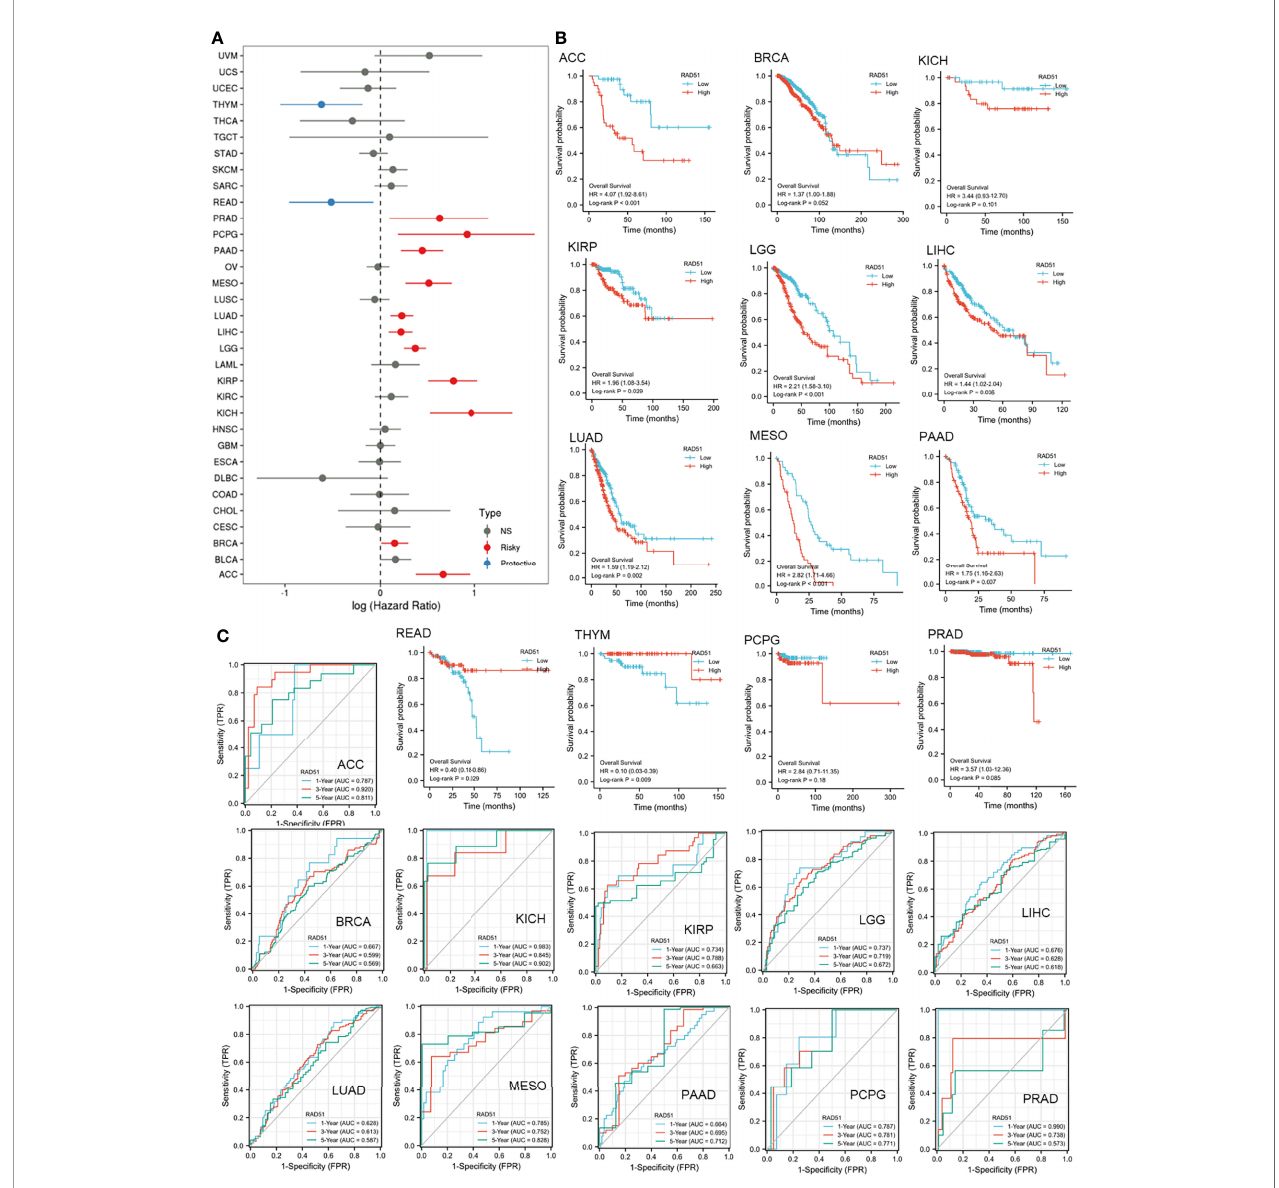
FIGURE 4 | The prognostic value of RAD51 in cancers. (A) Univariate Cox regression analysis of RAD51 for overall survival in different cancer types. (B) The overall survival KM plot and log-rank analysis of high (50-100%) and low (0-50%) RAD51 patients of signi fi cant cancer types in Cox regression. (C) Time-dependent overall survival ROC of RAD51 in signi fi cantly risky cancer types in Cox regression (1-, 3-, and 5-year